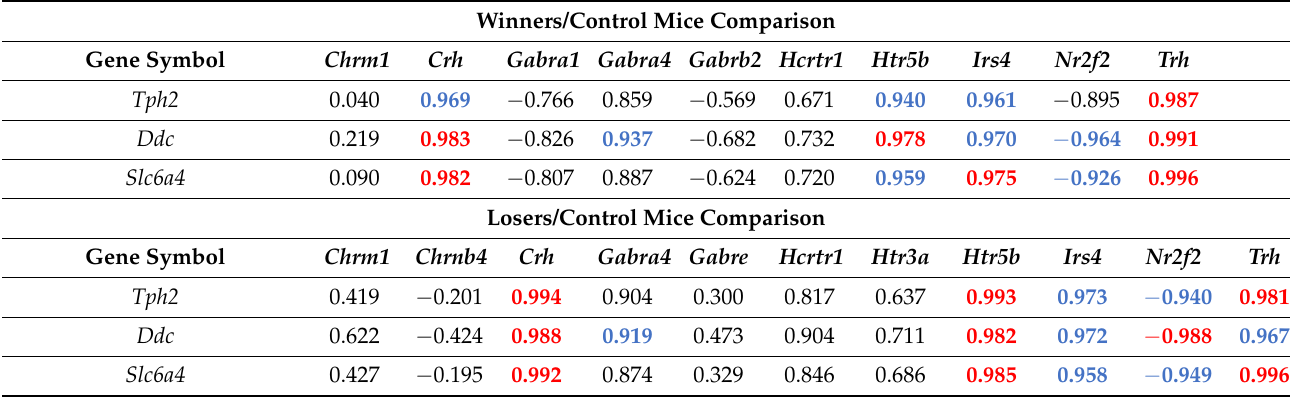
Table 5. Correlation between the mRNA level of genes encoding proteins participating in the synthesis and transport of serotonin and the expression of genes coding for hormones or receptors of neurotransmitters or